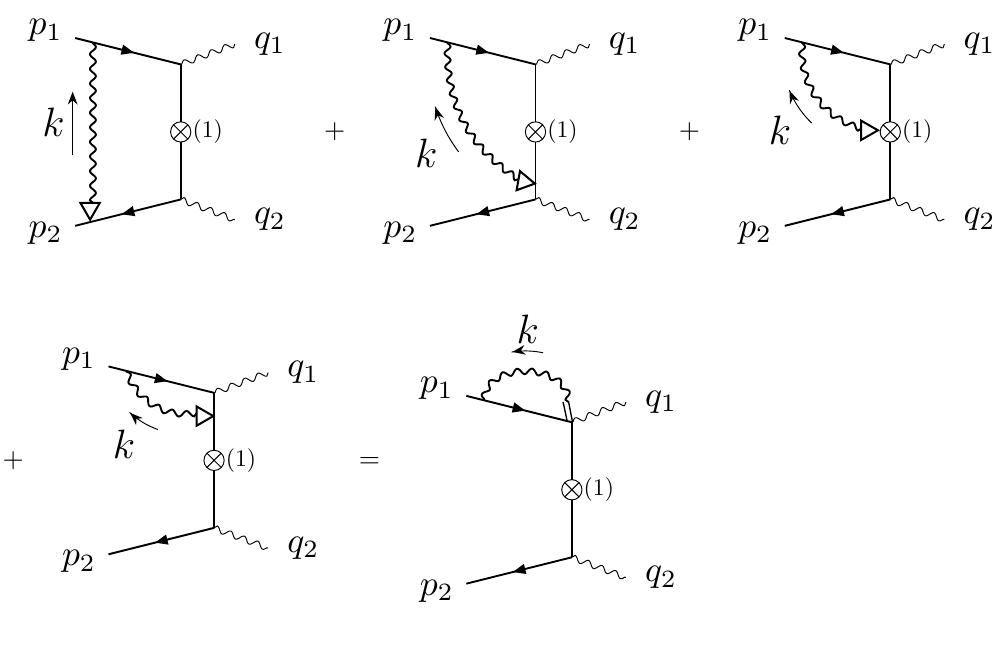
Figure 19. Illustration of a Ward identity that must be satisfied by the UV counterterms for one- loop self energy and vertex subgraphs. Note that we are referring to counterterms at the integrand level, and the counterterm designations in the figure correspond to functions whose dependence on the loop momentum l is suppressed in the